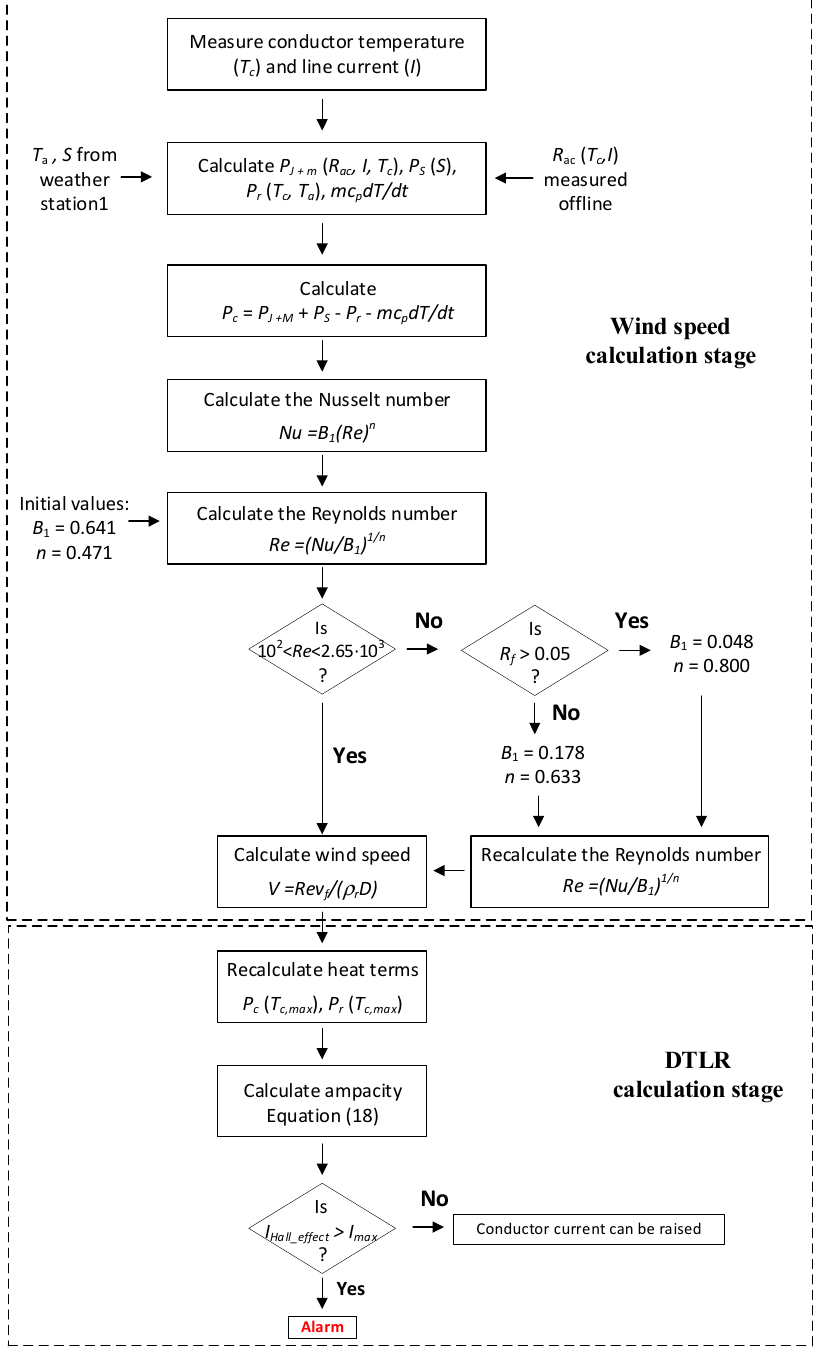
Figure 2. Proposed DTLR calculation method.